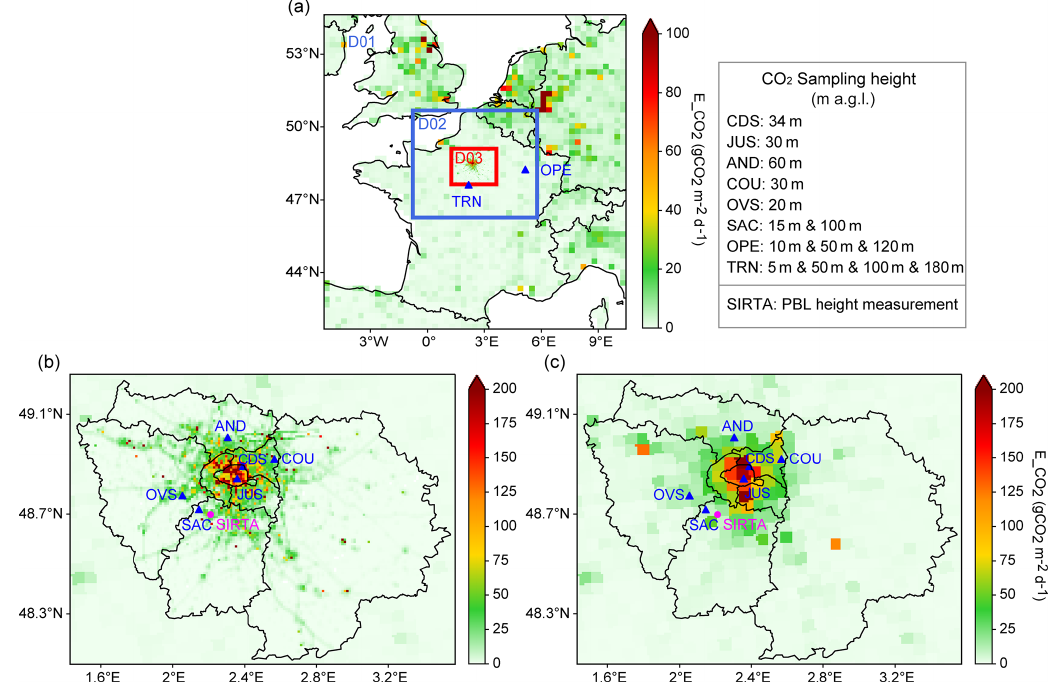
Figure 1. (a) Three domains of WRF-Chem that are used for the simulations discussed in this study, together with the large-scale CO 2 emission for a weekday in November; distributions of CO 2 emissions for a typical weekday in November from the (b) AirParif and (c) IER inventories. The bottom two maps show the location of six CO 2 measurement stations (blue triangle), one PBL height measurement station (magenta circle), and the administrative limits of the Île-de-France region.